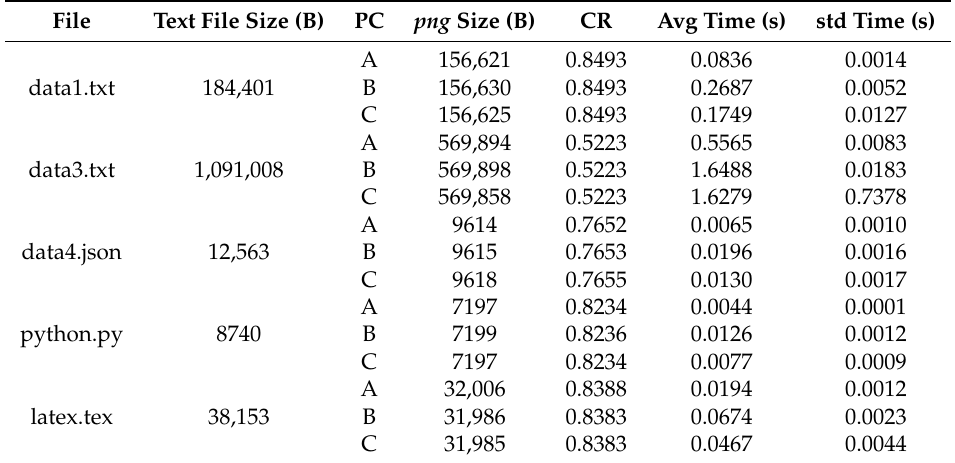
Table 1. Results for selected test files using variant 1 of the method (extended ASCII coding). The list of columns includes filename, size of the text file, PC specification identifier, size of the png file, CR, average time needed to create the png file and standard deviation of the time. The script has been run 100 times.